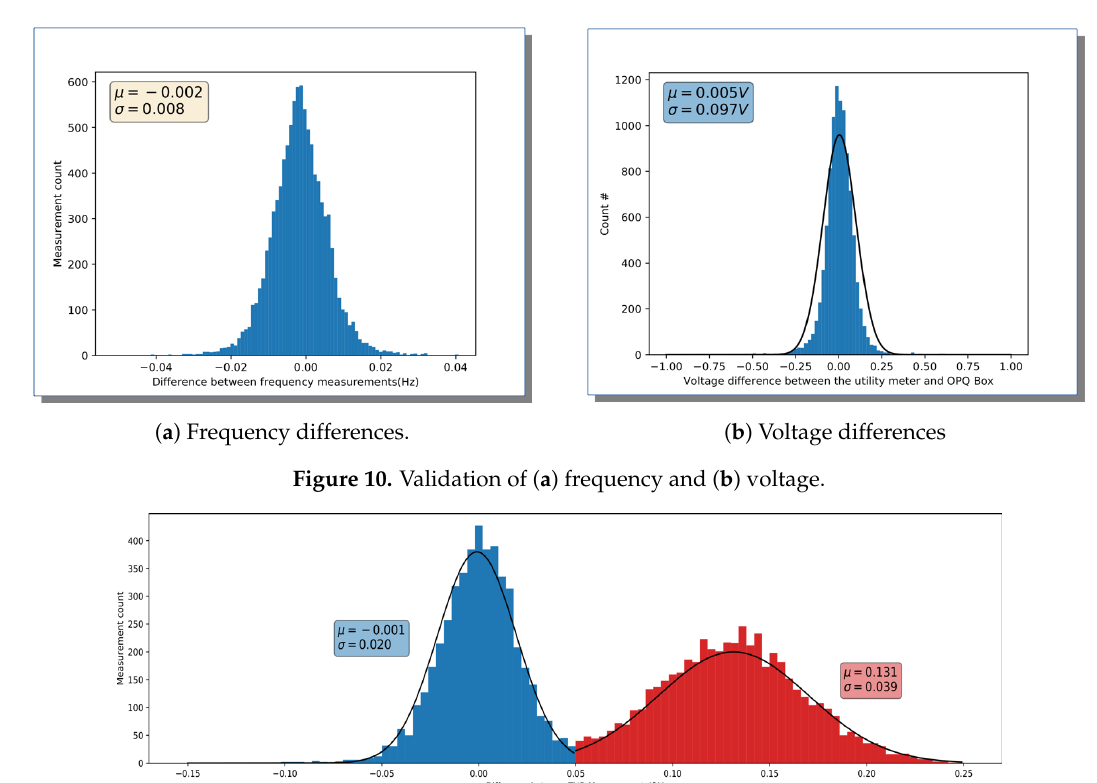
Figure 11. Total harmonic distortion (THD)